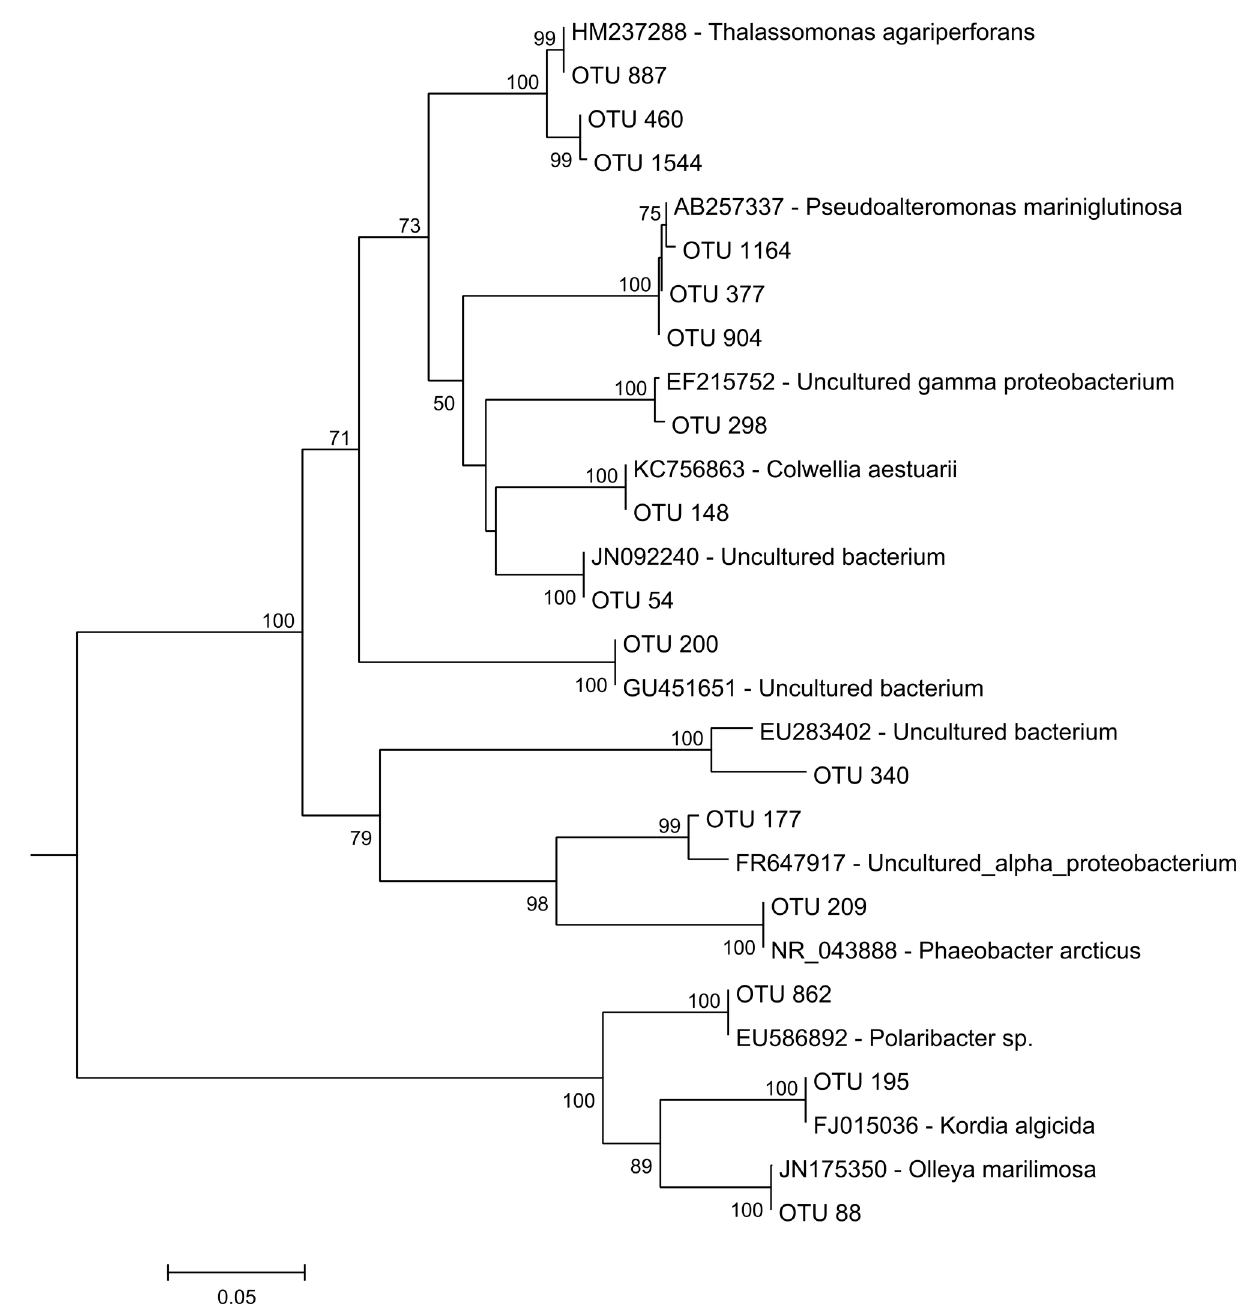
Figure 6. Neighbour-joining phylogenetic tree (16S rRNA gene sequences) of the most dominant OTUs in turbot and sole RAS and their closest relatives (accession number-species). Bootstrap values generated from 500 replicates. Values lower than 50% were